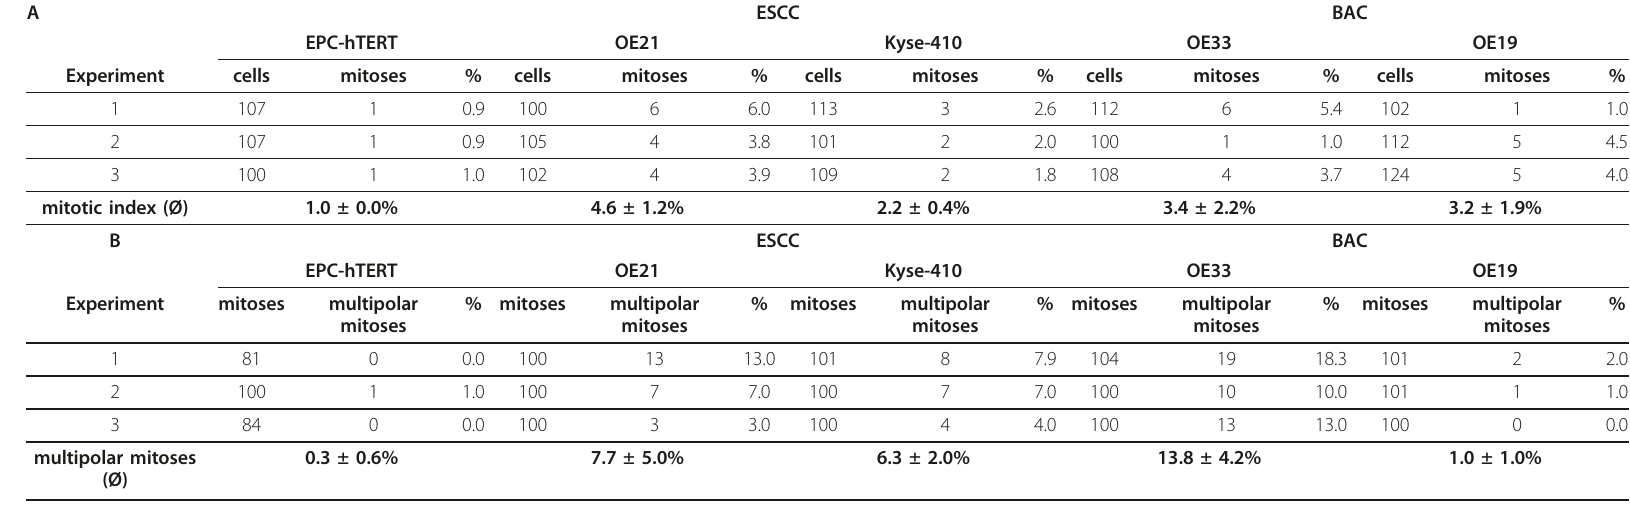
multipolar mitoses (Ø) (A) Summary of the evaluation of the mitotic index. In three independent experiments, about 100 cells were counted and the number of mitoses therein was determined after Aurora-A immunofluorescence staining. The table also provides mean and ± standard deviation of the percentage of mitoses. (B) Summary of the evaluation of the index of multipolar mitoses. In three independent experiments, about 100 mitoses were counted and the number of multipolar mitoses therein was determined after Aurora-A immunofluorescence staining. The table also provides mean and ± standard deviation of the percentage of multipolar